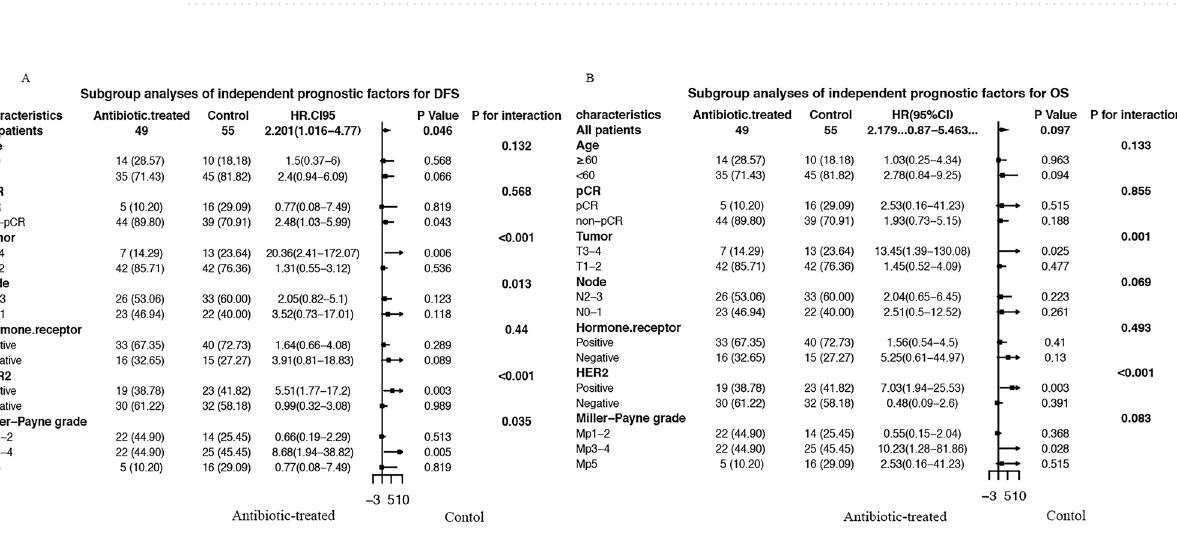
Table 3. Univariate and multivariate analyses of OS in BC patients. BC breast cancer, OS overall survival, ATB antibiotics; Significant. codes: 0 ‘***’ 0.001 ‘**’ 0.01 ‘*’ 0.05 ‘.’ 0.1 ‘ ’ 1.